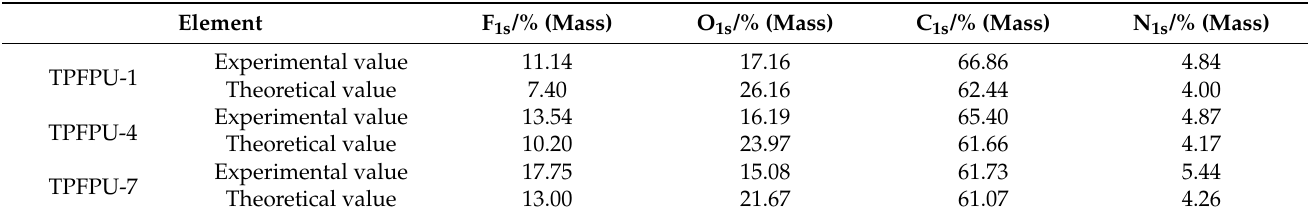
Table 2. The theoretical and experimental atomic compositions of the TPFPU latex films.